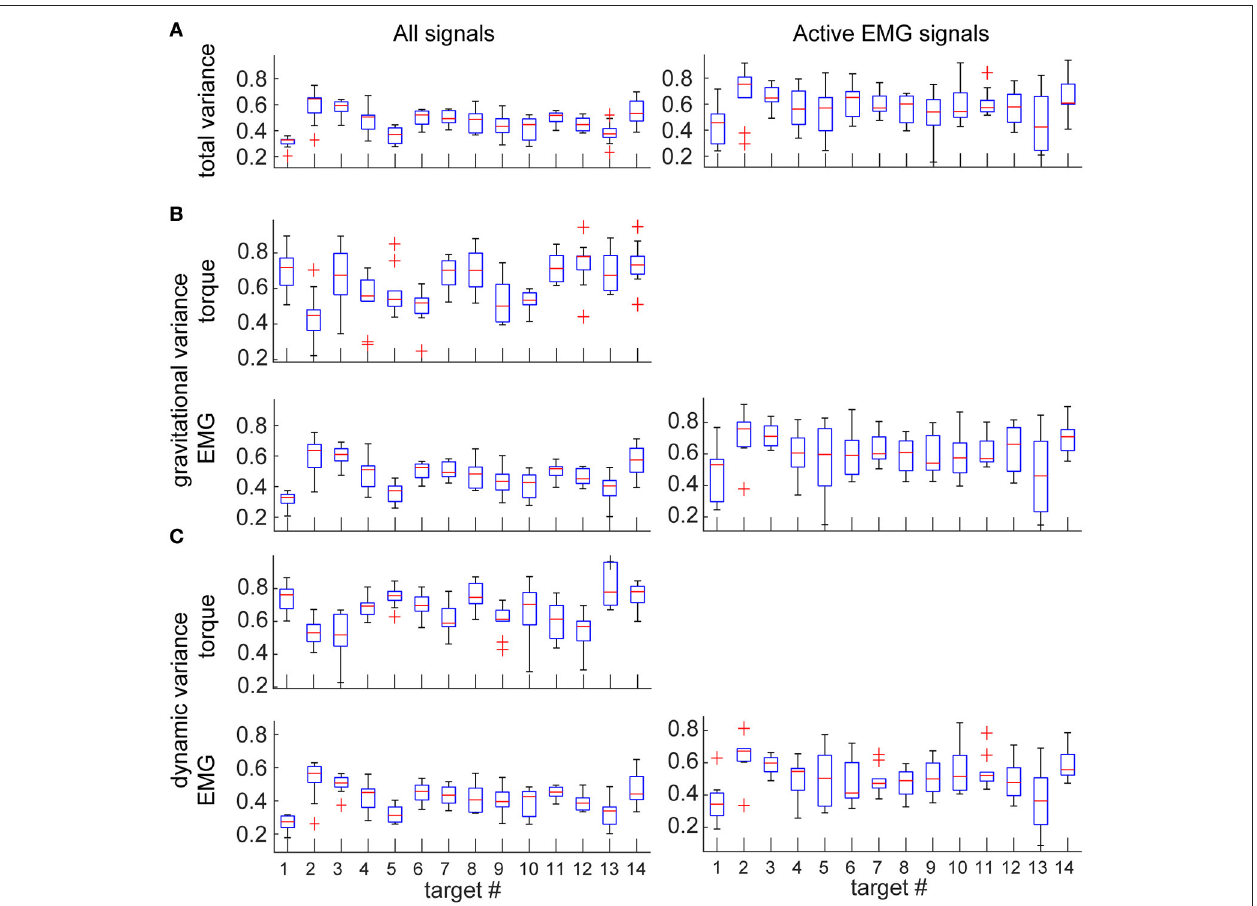
FIGURE 5 | Variance accounted for by the individual components in EMG and torques per movement direction. Values are means across subjects and signals; boxes indicate ranges of 25 and 75 percentiles in data; error bars show standard deviations; red crosses indicate outliers. Plots in the left column show values across all EMG and torque signals; plots in the right column show values from a subset of EMG signals that were active > 30% of maximal per movement per subject. (A) Total variance accounted for by torque decomposition of EMG per movement direction. (B) Relative variance accounted for by gravitational principal component. (C) Relative variance accounted for by dynamic principal